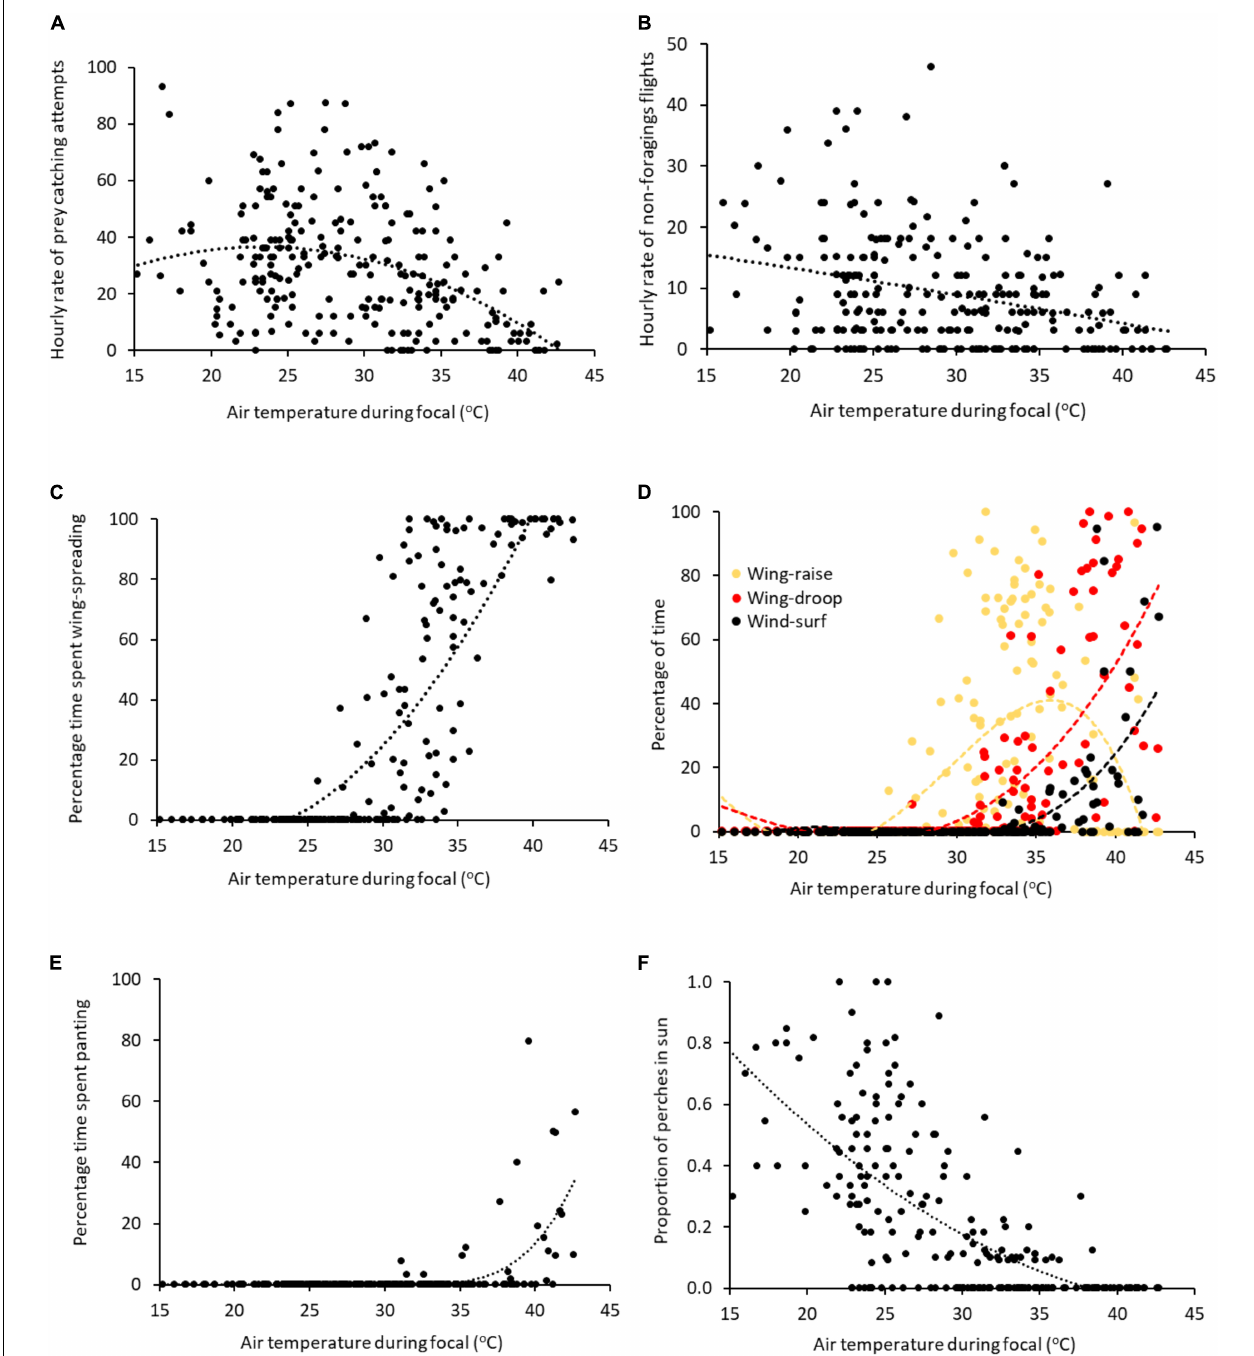
FIGURE 2 | The relationship between air temperature and (A) hourly rate of prey catching attempts and (B) non-foraging flights > 5 m, and percentage of time devoted to (C) any form of wing-spreading, (D) wing-raising, wing-drooping and wind surfing, and (E) panting, and (F) proportion of perches located in direct sun. Showing raw data with polynomial trend lines generated by Microsoft Excel v2111.